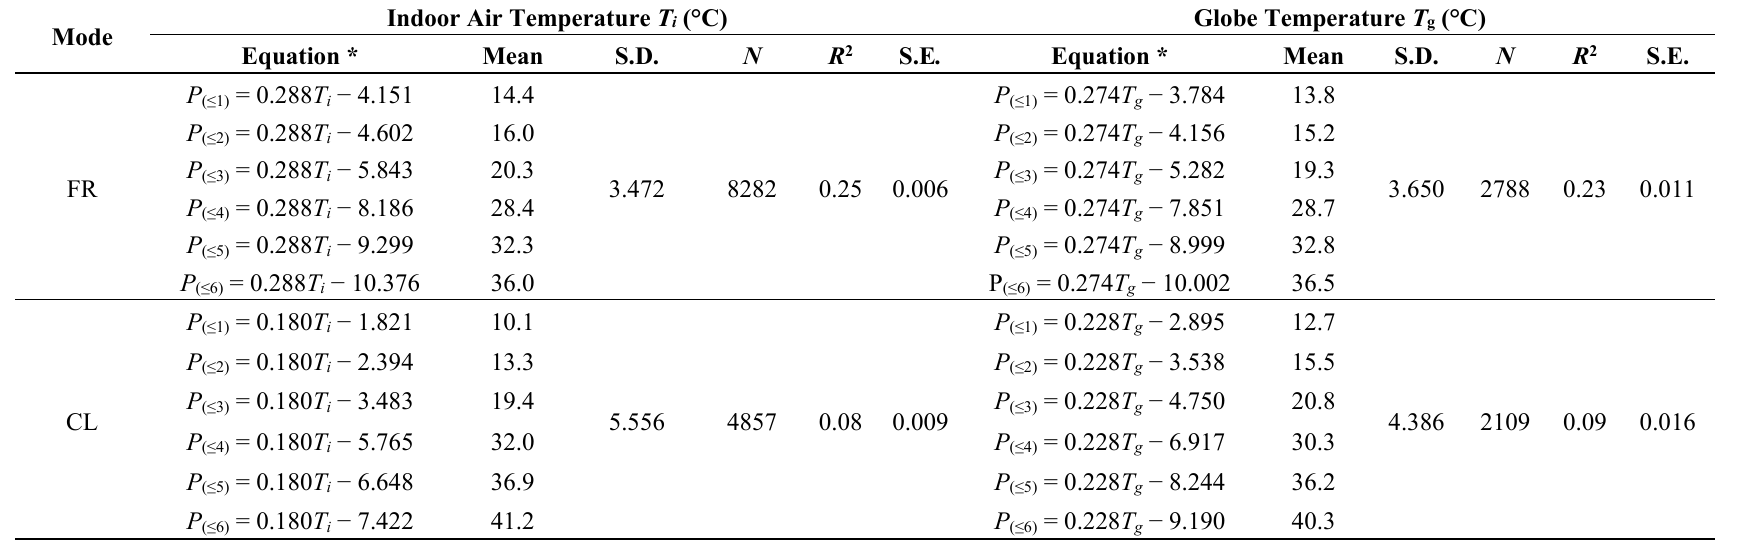
Table 7. Percentage of thermal sensation in FR and CL